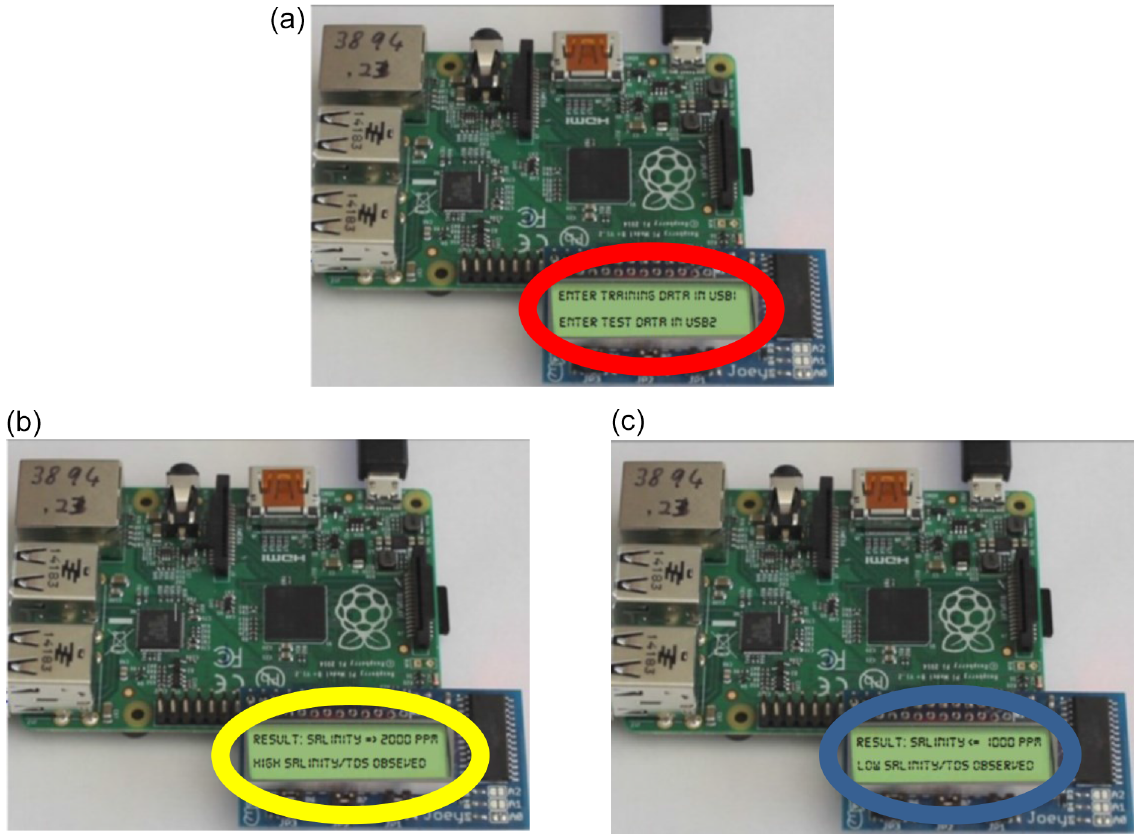
Figure 8. (a) Integrated device display with Raspberry Pi (red circle), (b) the 2000ppm salinity result (yellow circle), and (c) the 1000ppm salinity water result (blue